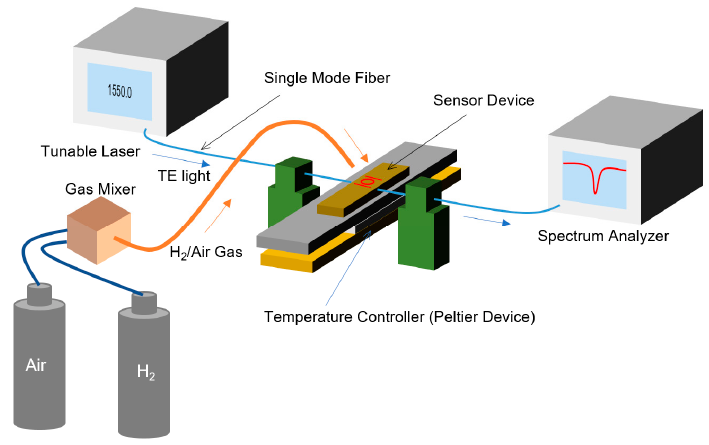
Figure 7. Schematic measurement setup for sensing characteristics of the MRR sensor.